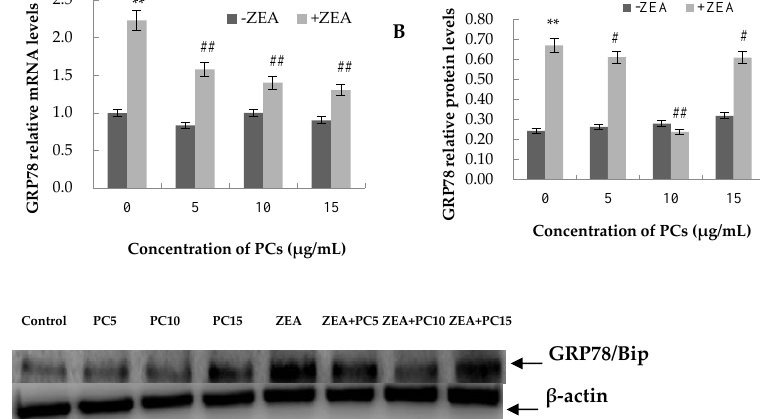
Figure 13. Effects of different concentrations of proanthocyanidins (PCs) on zearalenone (ZEA)-induced relative expression of mRNA ( A ) and GRP78 protein ( B ) in MODE-K cells. PCs could significantly reverse the ZEA-induced increase in GRP78 expression. When the concentration of PCs was 10 µ g/mL, PCs could significantly decrease the increase in expressions induced by ZEA. ** p < 0.01 vs. control group; # p < 0.05 and # # p < 0.01 vs. ZEA-treated